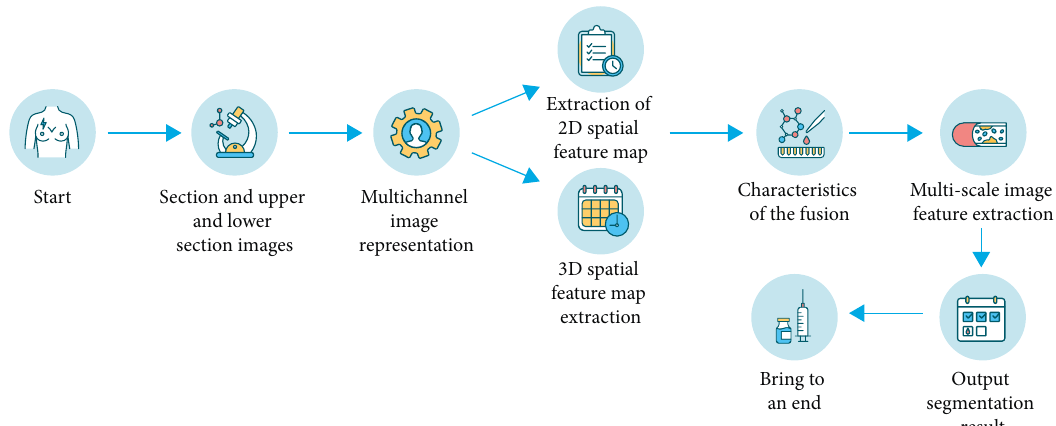
Figure 1: Flowchart of MRI scan for breast cancer